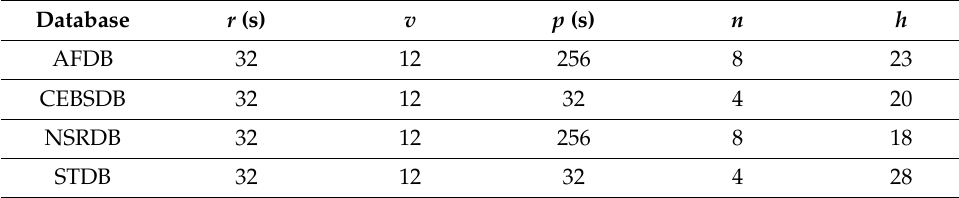
Table 8. Variables used for all time separation test.